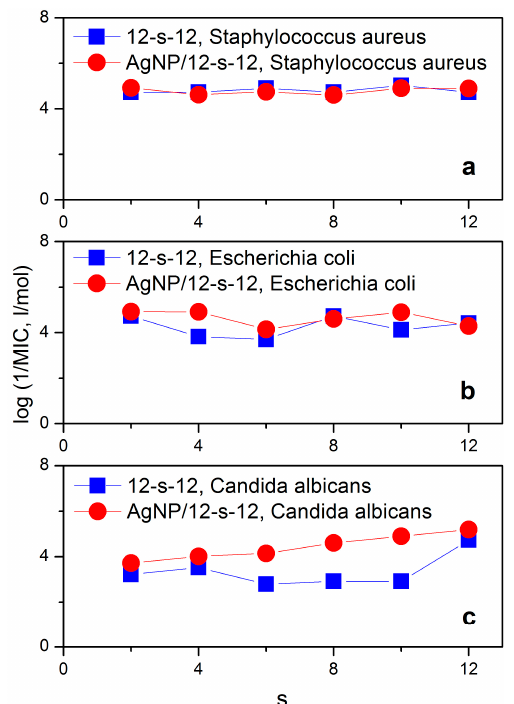
Figure 13. Comparison of microbicidal activity of Ag/12- s -12 nanoparticles and gemini surfactants 12- s -12 against individual bacterial strains and yeast.